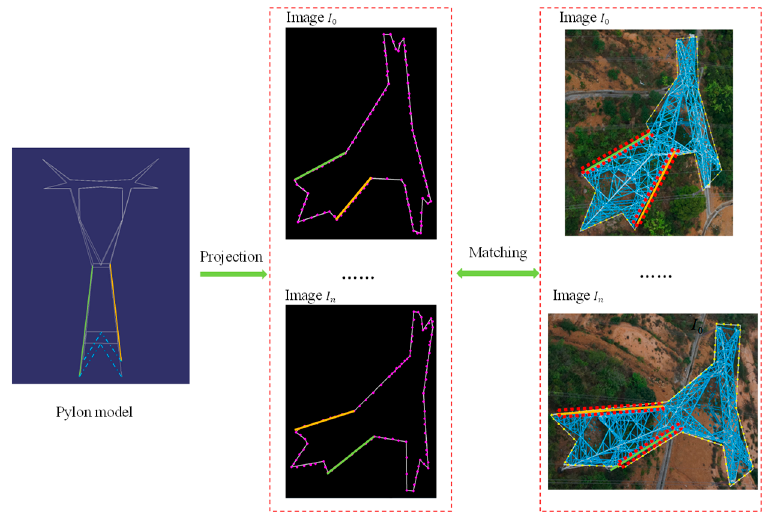
Figure 8. The workflow of correlation confirmation between 3D line segments of model and 2D line segments of pylon legs in images.